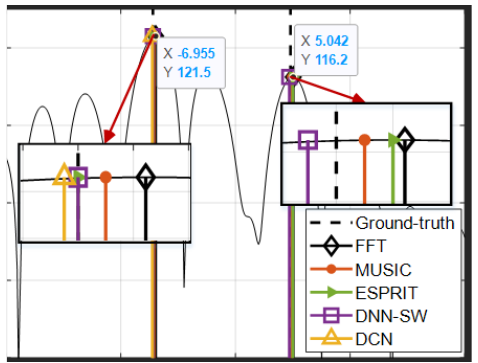
Figure 11. The DOA estimation of two different corner reflectors. Table 3. DOA estimation results of the real data.